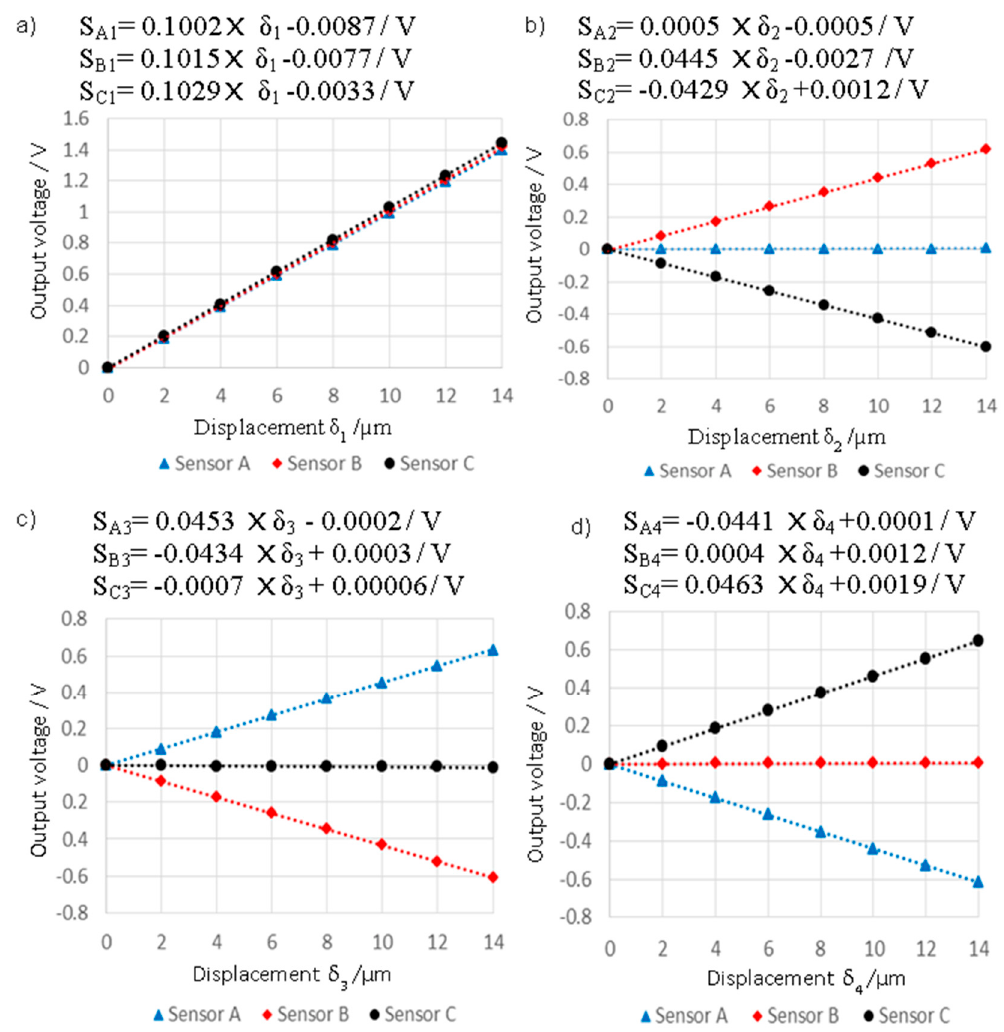
Figure 10. Output voltage from three capacitive sensors against the displacement of the probe tip in each of the four displacement ranges.